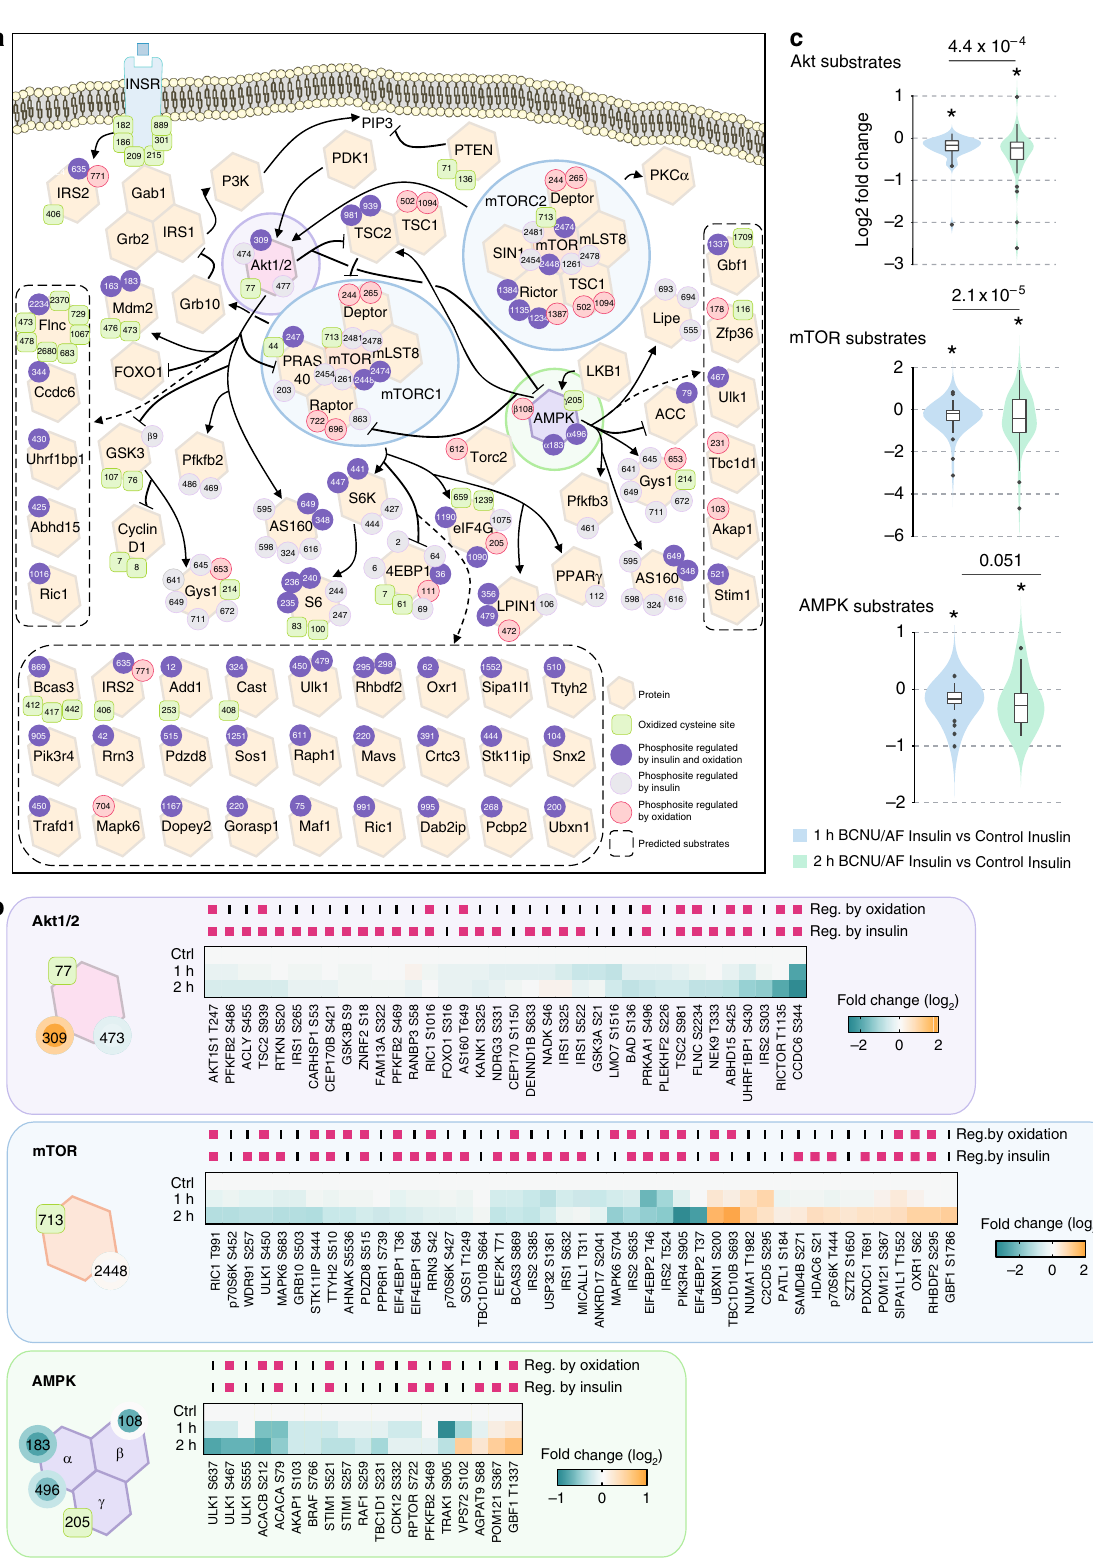
Fig. 3 Integrative analysis of oxidative stress-regulated phospho-signalling networks. a A network diagram visualising the crosstalks of redox- and phospho- signalling. Oxidized cysteine sites (green squares) and phosphosites regulated by oxidation (red circles), insulin (grey circles) or both (purple circles) on key kinases and substrates of Akt, mTOR and AMPK signalling pathways were highlighted. b Heatmaps of standardised phosphorylation levels of Akt, mTOR, and AMPK substrates. Those that were signi fi cantly altered by oxidation and/or insulin were highlighted. c Boxplots for phosphorylation changes of Akt, mTOR and AMPK substrates with either 1 or 2h BCNU/AF treatments vs controls in the presence of insulin. Boxes capture lower quartile and upper quartile with median displayed as a horizontal line in the middle; whiskers are min and max. A one-sided Bartlett Test was used to compare if the variance in (2h BCNU/ AF) was greater than(1 h BCNU/AF) treatment, following insulin stimulation. A one-sided t -test was used to compare if the mean was less than 0 ( p